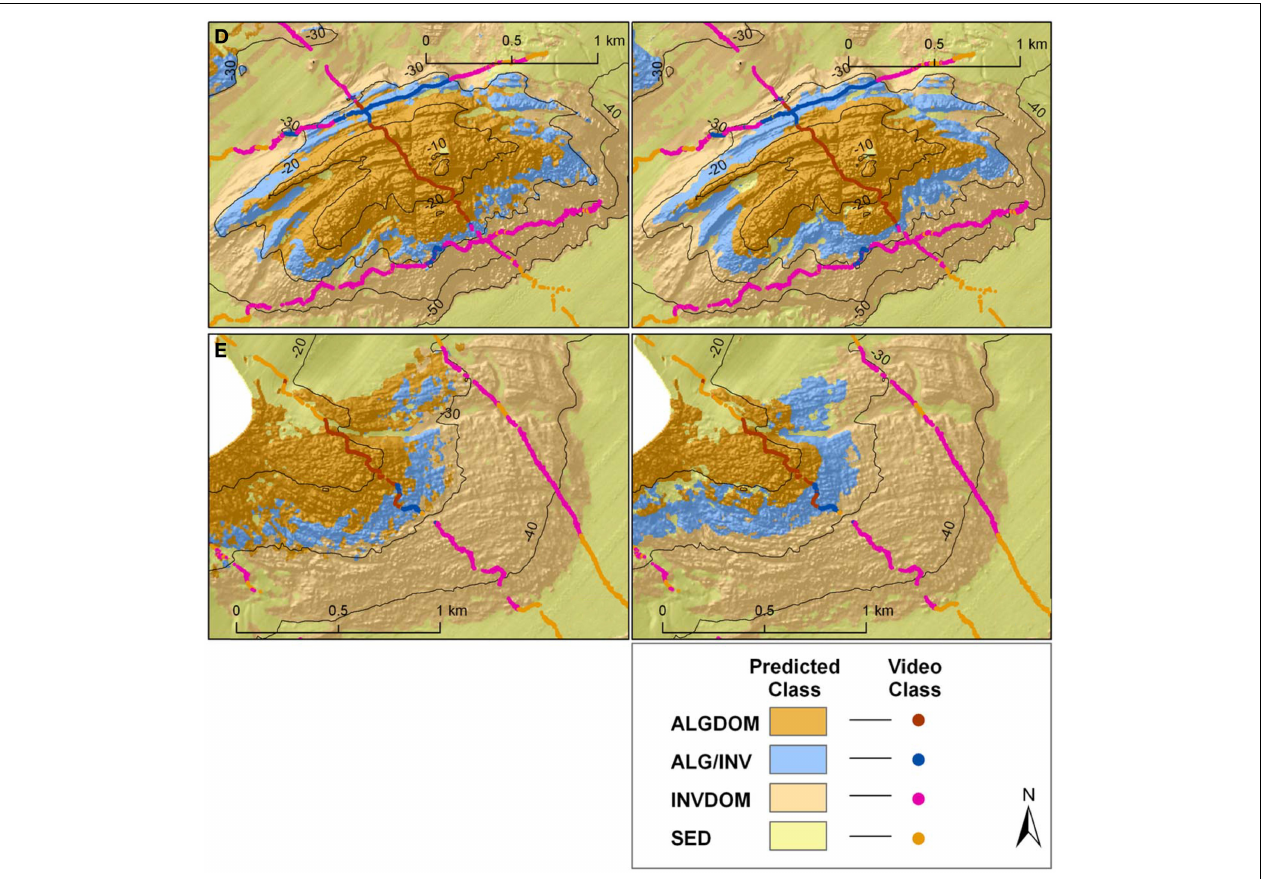
FIGURE 9 | Classified habitat maps of representative reef systems east of Cape Otway overlaid with classified observation data from towed video transects. Locations of reefs D and E are shown in Figures 1 , 4 .